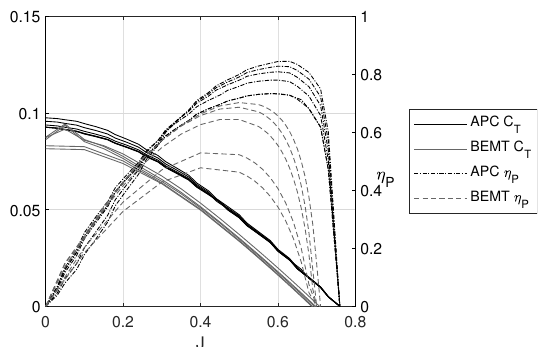
Figure 11. BEMT and APC C T , η P of a 18 × 12 APC propeller. Each line represents a constant RPM increasing from bottom to top of the